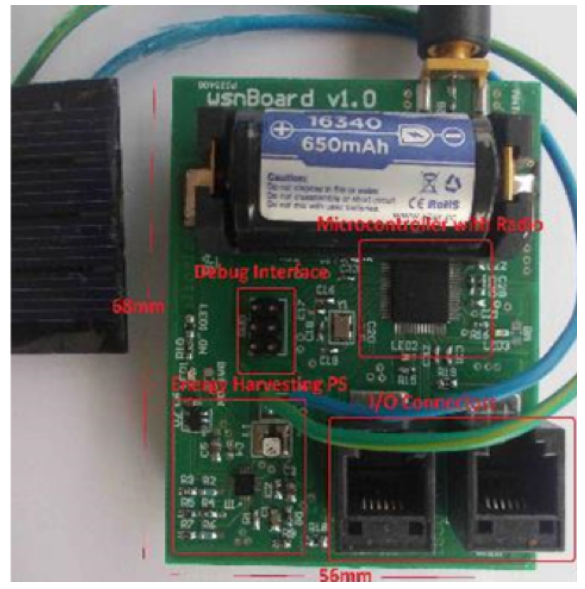
Figure 17. Physical Parts of the IoT